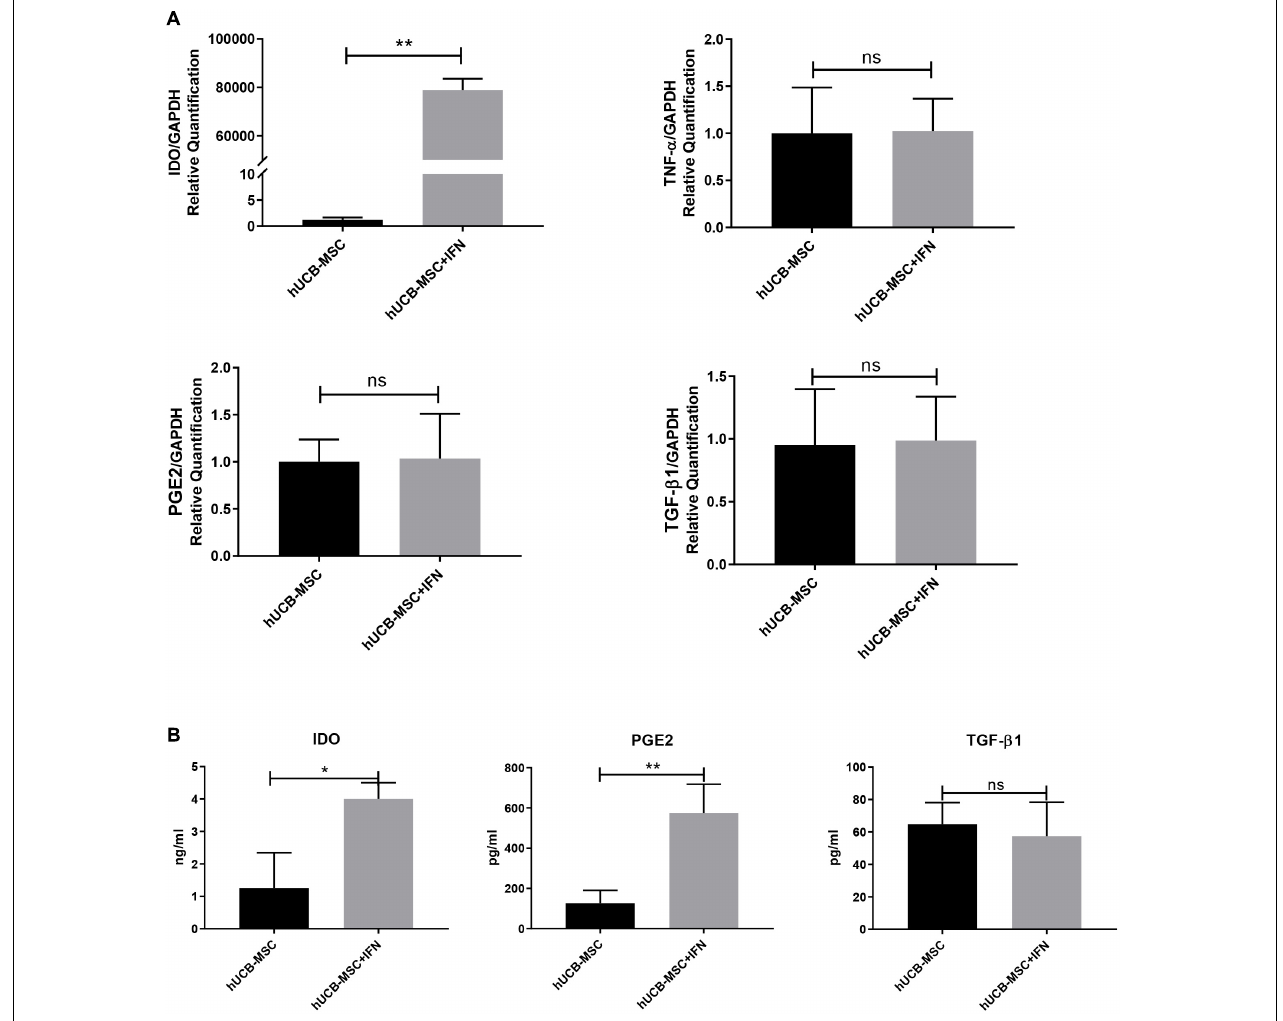
FIGURE 3 | hUCB-MSCs show hyper-immunomodulatory potency with the stimulation of IFN- γ . (A) qPCR for IDO, TNF- α , PGE2, and TGF- β 1 mRNA expression level in hUCB-MSCs with or without IFN- γ stimulation. (B) hUCB-MSCs were cultured in the presence of IFN- γ for 2 days, after which IDO, PGE2, and TGF- β 1 levels in the supernatant were determined using ELISA. The results shown are from duplicate cultures performed in parallel. * p < 0.05, ** p < 0.01, and ns, no significant